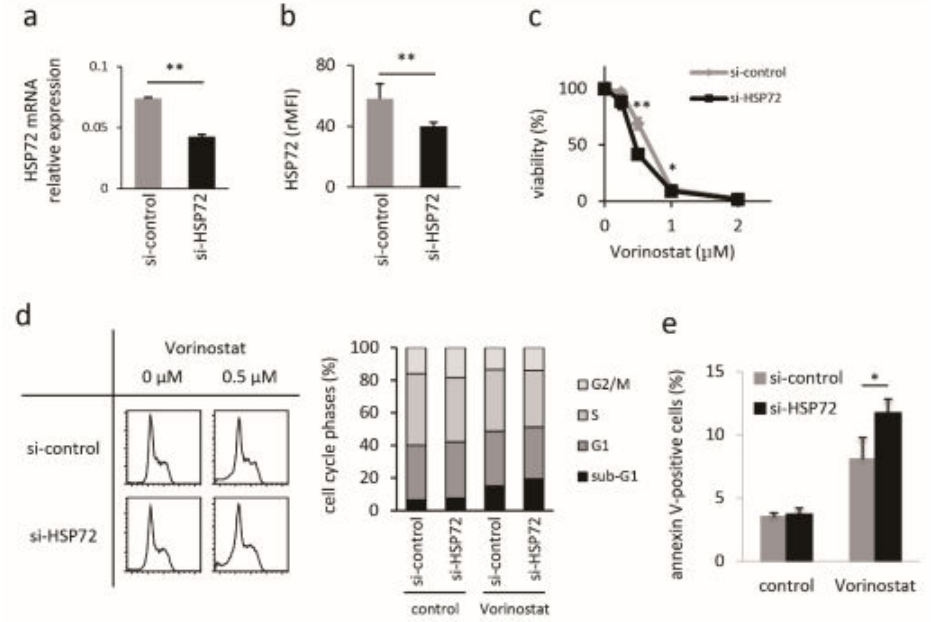
Int. J. Mol. Sci. 2021 , 22 , 11258 4 of 12 Figure 2. Characterization of HSP72-knockdown Hut78 cells. HSP72 mRNA expression for MOCK (gray bar) and HSP72-knockdown (black bar) Hut78 cells, normalized to GAPDH expression levels (( a ), n = 2). Flow cytometric analysis of HSP72 protein expression in MOCK (gray bar) and HSP72 knockdown (black bar) cells, showing the relative mean fluorescence intensity (rMFI) + SD (( b ), n = 3). Proliferation assay with vorinostat using the WST-1 assay kit (( c ), n = 4). : MOCK, and ■ : HSP72 knockdown Hut78 cells. Assessment of the influence of HSP72 knockdown on the antitumor effects of vorinostat. Representative images are shown in the left panels, and the summary is shown in the right panel ( d ). Assessment of apoptosis by annexin-V assays ( e ). * p < 0.05, ** p < 0.01, by student t-test.